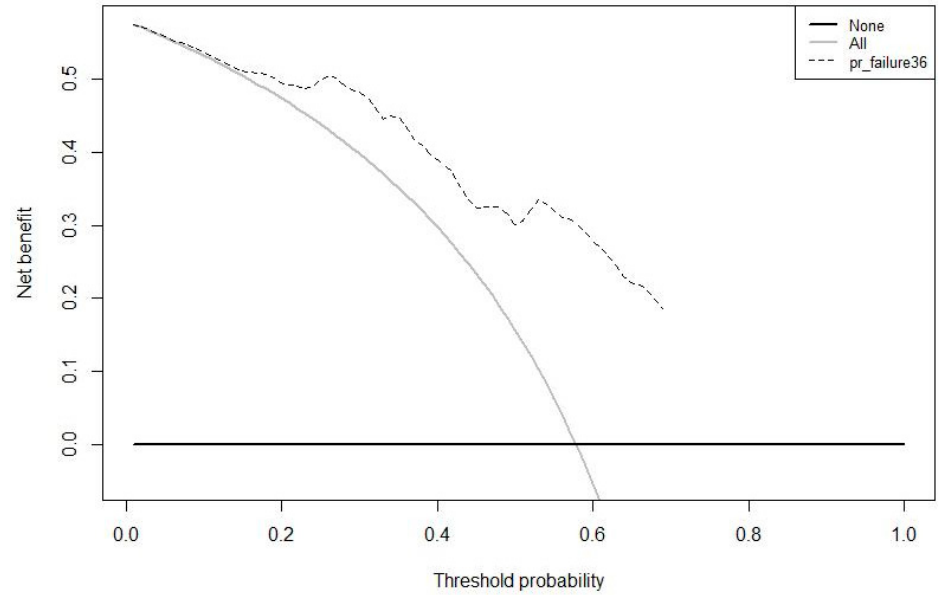
Figure 4. Decision curve analysis. Clinical utility associated with the clinical application of the model at three years, expressed in terms of net benefit.